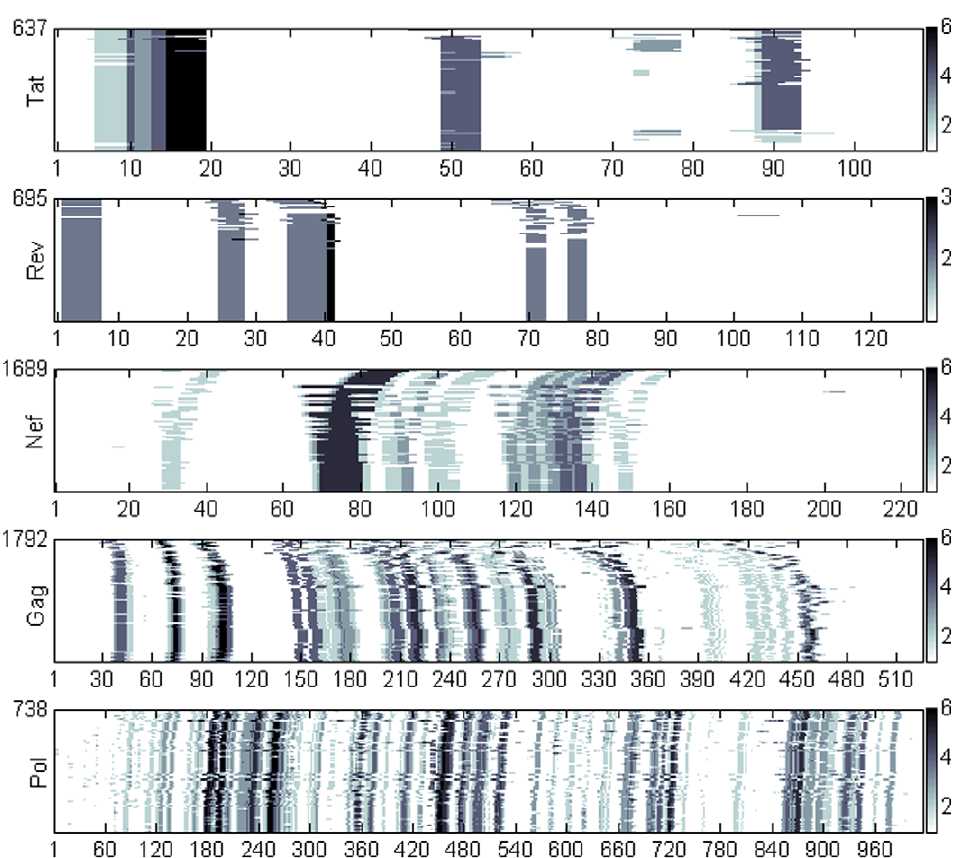
Figure 2. Hotspots on HIV protein sequences. Amino acid sequence positions of motif hotspots are shown on the horizontal axis. The vertical axis identifies the number of viral protein sequences in the alignment. Color intensity is proportional to the number of hub proteins with enriched hotspot motifs among its immediate neighbors. Regions highlighted in this figure have at least two different hub proteins associated with them.